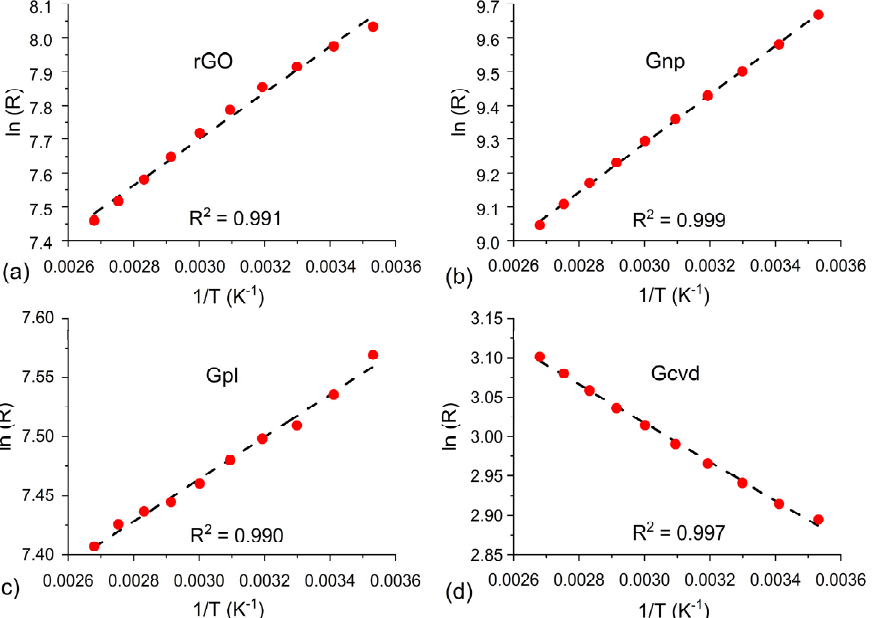
Figure 5. Logarithm of resistivity versus reciprocal temperature and confirmation of linearity, including the coefficient of determination, for ( a ) rGO, ( b ) Gnp, ( c) Gpl, and ( d ) Gcvd. The response time of a sensor is defined as the time it takes to reach 90% of the maximum change in resistance for the variable change between two stable levels (in this case, temperature). This time is referred to as t 90 . The evaluated response time is defined for the temperature change from 20 °C to 30 °C that occurred in the 20th minute of the measurement. A detail of the temperature change area for all tested sensors and the t 90 value labeling is shown in Figure 6. The decreasing sensor responses were converted to an absolute value to compare the sensors together. The Gcvd sensor had the shortest response time of 68 s, followed by the Gnp sensor with 89 s. The rGO and Gpl sensors had the longest response times of 121 s and 125 s, respectively. It should be noted that the t 90 of the temperature change (from 20 °C to 30 °C) in the measuring chamber was 59 s. Figure 6. Sensors’ response time to temperature step change from 20 °C to 30 °C with the marked value t 90 for each sensor (and also temperature rise). The characteristic parameter of temperature sensors is the temperature coefficient of resistance ( TCR ), which is described by the following equation: